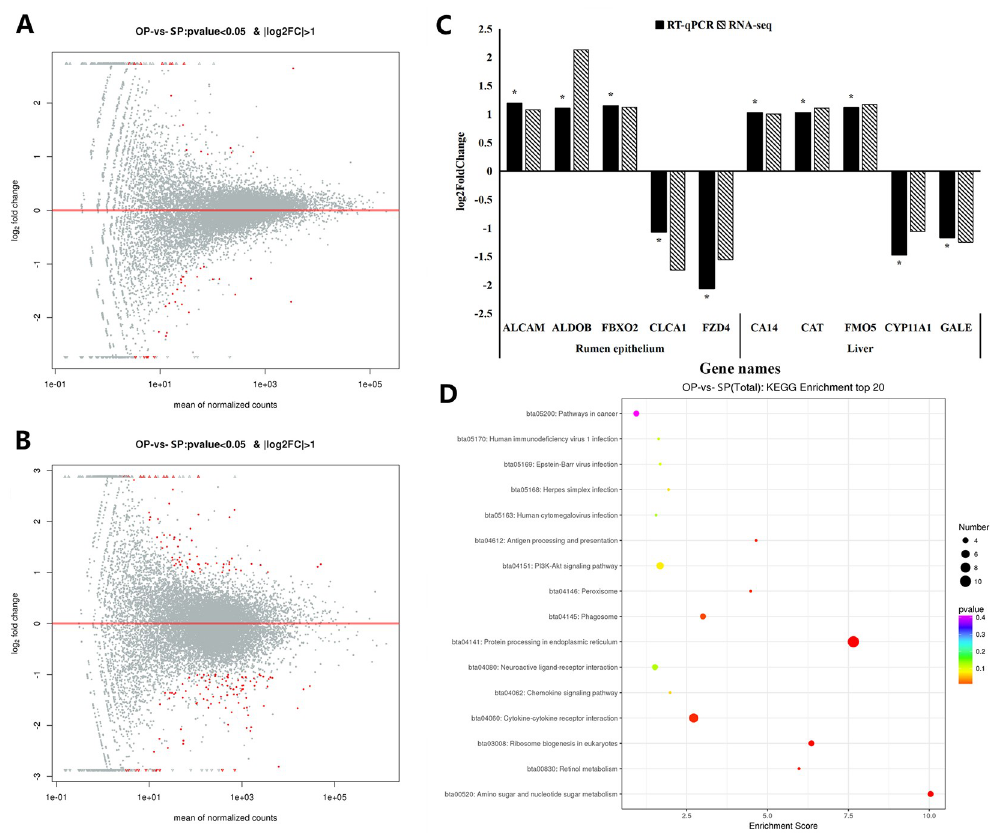
Fig 2. Analysis of differentially expressed genes (DEGs) in rumen epithelium and liver between calves fed OP and SP. DEGs in rumen epithelium (A) and liver (B), with red dots represent DEGs and gray dots represent all detected genes; (C) Fold-change of 10 genes determined by both RT-qPCR and RNA-sequencing methods; (D) KEGG annotate the DEGs in liver. OP, oscillating crude protein concentrations diet; SP, static protein diet.